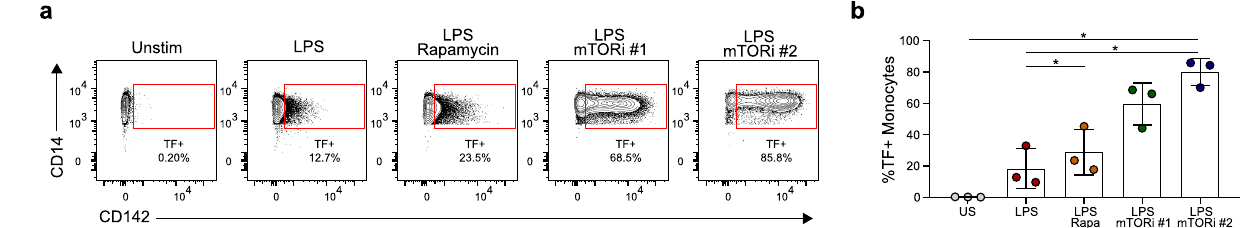
Fig. 2 mTOR inhibition potentiates surface expression of tissue factor on primary uninfected human monocytes following TLR4 stimulation. a , b Freshly isolated human monocytes from three independent donors were pretreated as indicated with rapamycin (100 nM) or one of two structurally distinct mTORi (AZD2014, mTORi #1; INK128, mTORi #2; each 5 μ M) or DMSO for 6 h and stimulated with LPS (1 μ g, 12 h) prior to staining Representative fl ow plot ( a ) and aggregate ( b ) represent gating on leukocyte/singlet/live/CD14 + . For b , signi fi cance was determined via one-way ANOVA and Tukey ’ s multiple comparisons. * p < 0.05. Error bars represent mean ± SD.